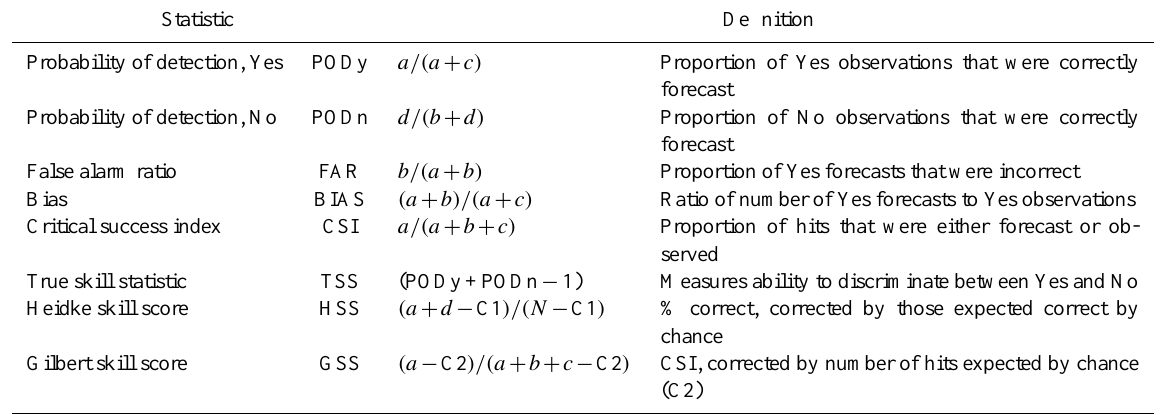
Table 1. Definitions of various meteorological standard forecast skill scores used to evaluate the performance of numerical predictive models. These constitute various combinations of the contingency values and the specific parameter of interest to a user depends on the needs of that particular